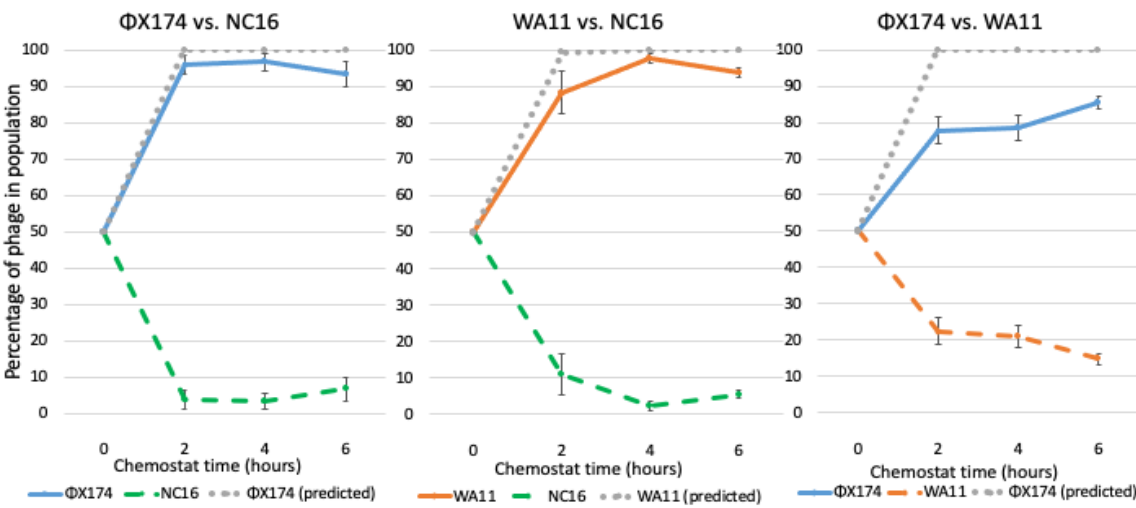
Figure 7. Population dynamics of Φ X174, WA11, and NC16 in pair competitions over time. All chemostats were inoculated at time zero with equal parts of each phage, as estimated by phage stock titers. Competitions were run in triplicate with samples taken at hours 2, 4, and 6. The gray dotted line indicates the predicted winning phage based on fitness. Error bars indicate standard error.